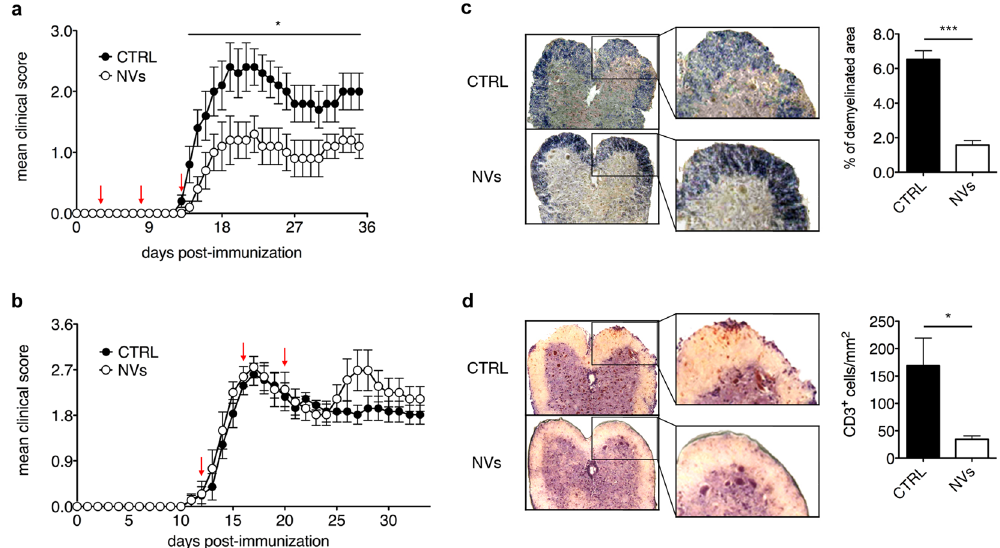
Figure 2. Preventive administration of ASC-NVs ameliorates EAE course. ( a ) MOG 35–55 -immunized C57Bl/6 mice were treated with PBS (CTRL condition) or 5 μ g ASC-NVs at 3, 8 and 13 dpi (red arrows). ASC-NVs significantly inhibited the mean clinical score and chronic EAE development, compared to CTRL condition (day 14 p = 0.041; day 15 p = 0.019; day 16 p = 0.048; day 17 p = 0.045; day 18 p = 0.046; day 19 p = 0.044; day 20 p = 0.033; day 21 p = 0.021; day 22 p = 0.019; day 23 p = 0.020; day 24 p = 0.030; day 25 p = 0.018; day 26 p = 0.018; day 27 p = 0.018; day 28 p = 0.030; day 29 p = 0.049; day 30 p = 0.048; day 31 p = 0.048; day 32 p = 0.041; day 33 p = 0.032; day 34 p = 0.032; day 35 p = 0.024). Data are the mean ± SEM of three independent